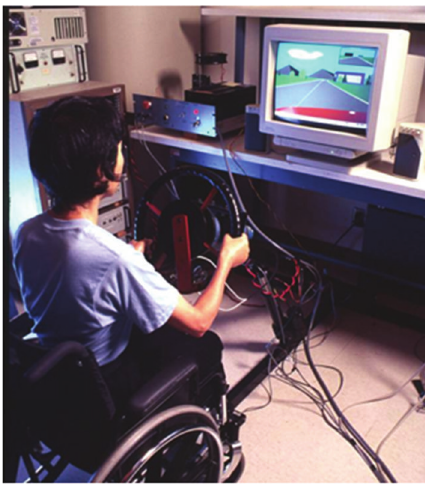
Figure 16: Driver’s SEAT. Reprinted with permission (funding: US Department of Veterans A ff airs Rehabilitation Research and Development Program).